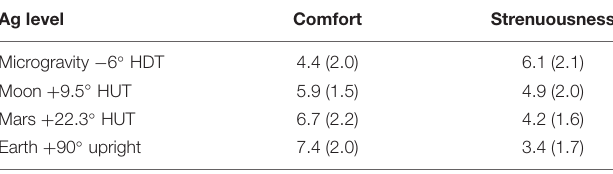
TABLE 4 | Exit survey results concerning perceived comfort and strenuousness during the experimental sessions [mean (SE), including 14 subjects] for all altered-gravity conditions (Microgravity − 6 ◦ HDT, Moon + 9.5 ◦ HUT, Mars + 22.3 ◦ HUT, Earth + 90 ◦